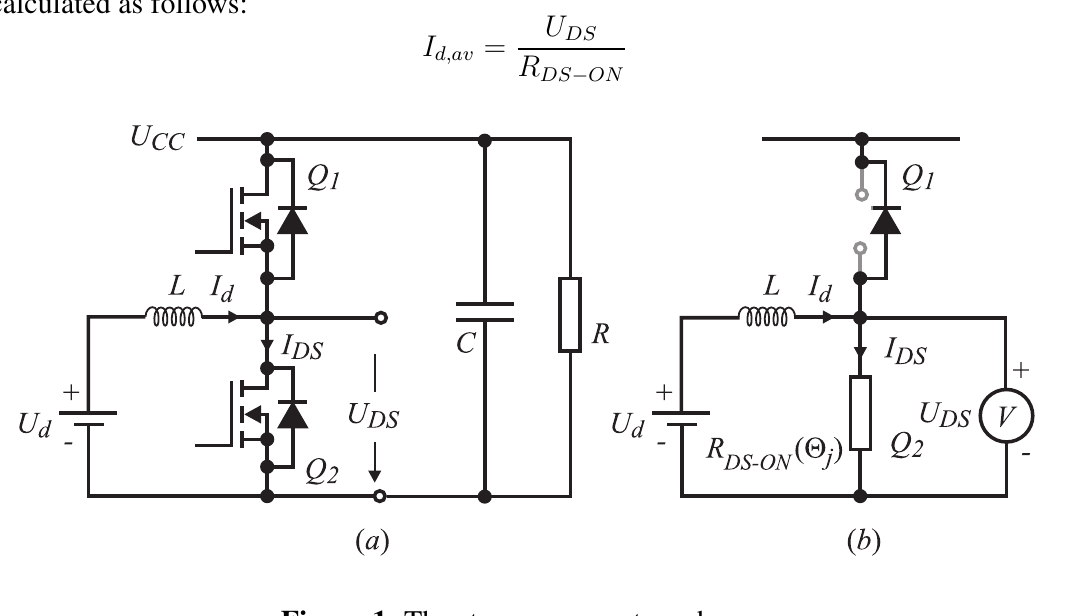
Figure 1. The step-up converter scheme.